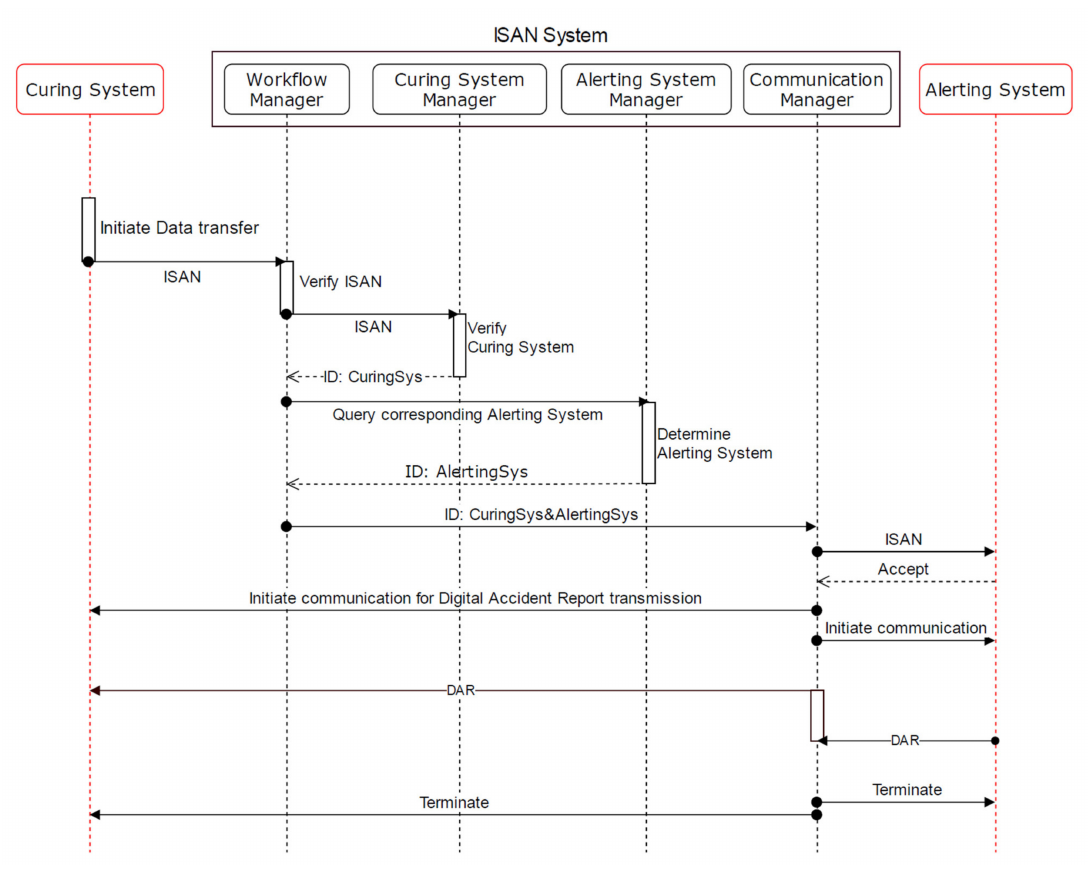
Figure 4. Curing system request data from alerting